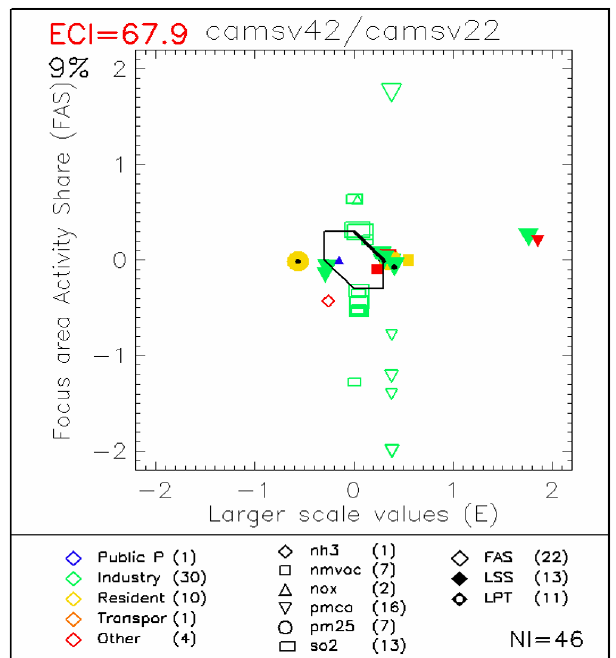
Figure 4. Overview diamond. Symbols and colors are used to dis- tinguish pollutants and sectors, respectively. The x - and y -axes in- dicate inconsistencies in country emissions ( ˆ E ) and urban share ( (cid:100) FAS), respectively, while the overview table provides information on the origin of the inconsistencies in terms of sector, pollutant, and country/city scale (FAS, LSS, LPT). The ECI indicator indicates the ratio between the magnitude of the maximum inconsistency and the assumed level of uncertainty ( β ). The percentage number indicates the fraction of inconsistencies ( β ≥ β t ) among the relevant emis- sions ( γ ≥ γ t ). See additional explanations in the